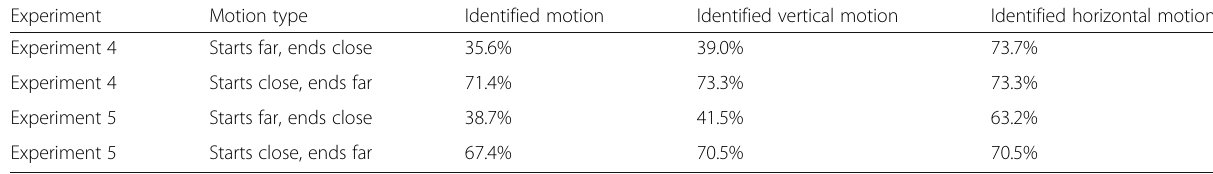
To be counted as noticing the motion overall, subjects had to get the motion direction correct. For the vertical component, they simply had to supply any direction that contained the correct vertical direction (e.g., ‘ up-left, ’ ‘ up, ’ or ‘ up-right ’ would be accepted), and for the horizontal component, any direction that contained the correct horizontal